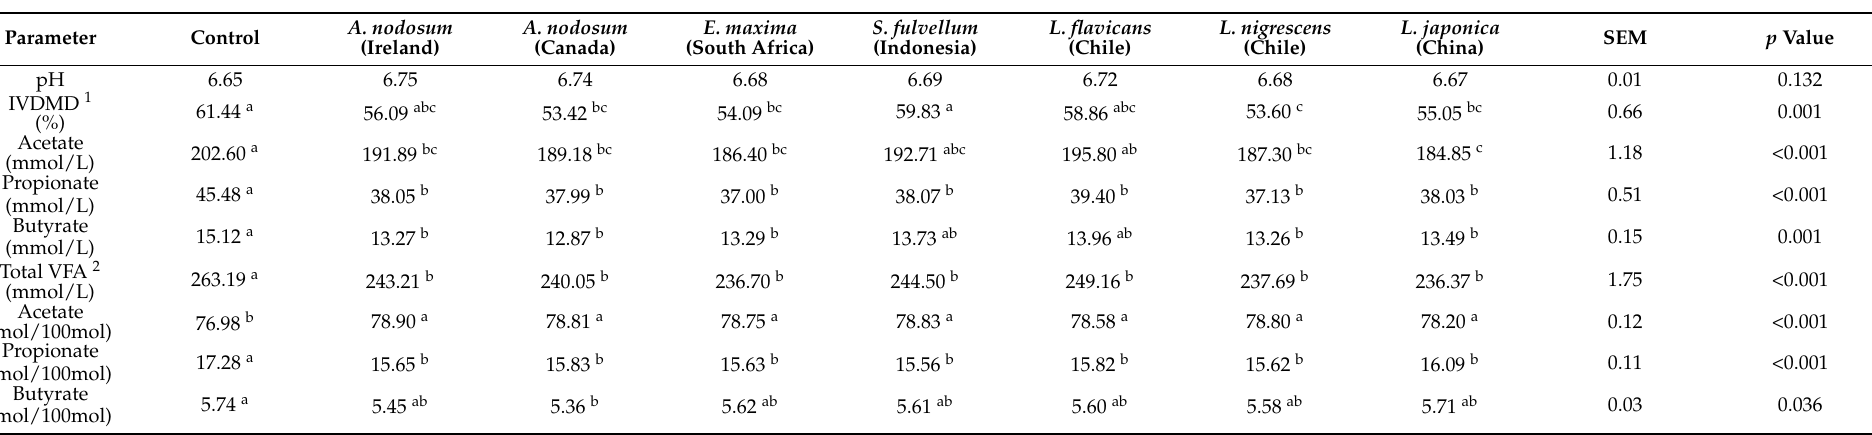
Table 7. Effect of different brown seaweeds as feed on rumen fermentation characteristics from 24 h in vitro incubation ( n = 4) (Experiment 2). Parameter